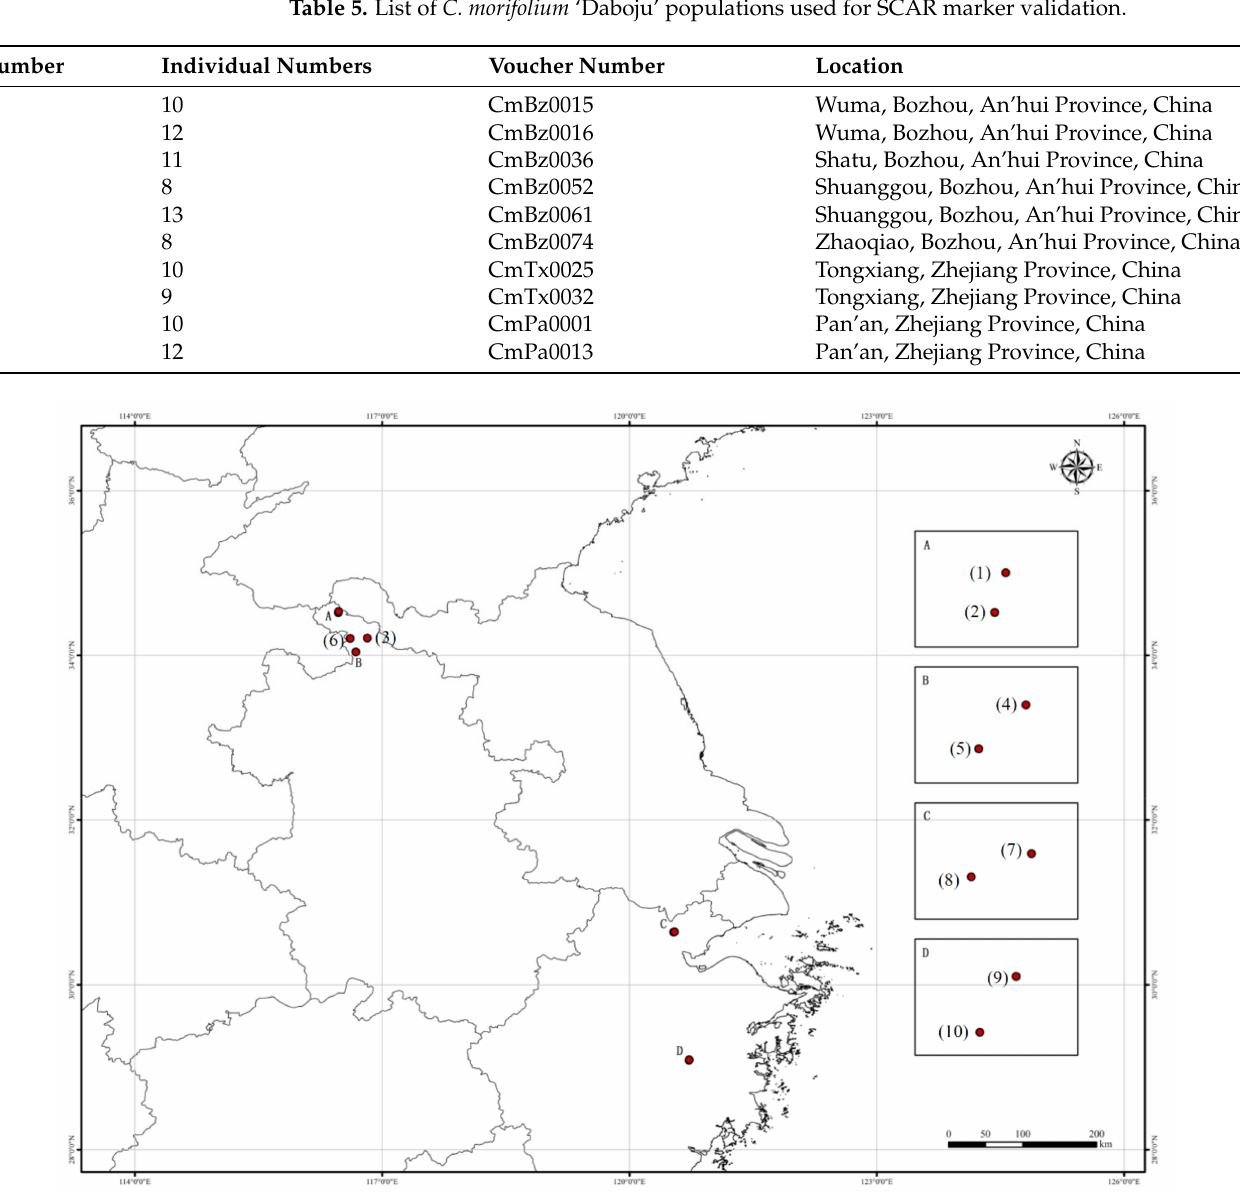
Figure 9. Sampling locations of 10 C. morifolium ‘Daboju’ populations. Numbers 1–10 are the same as those in Table